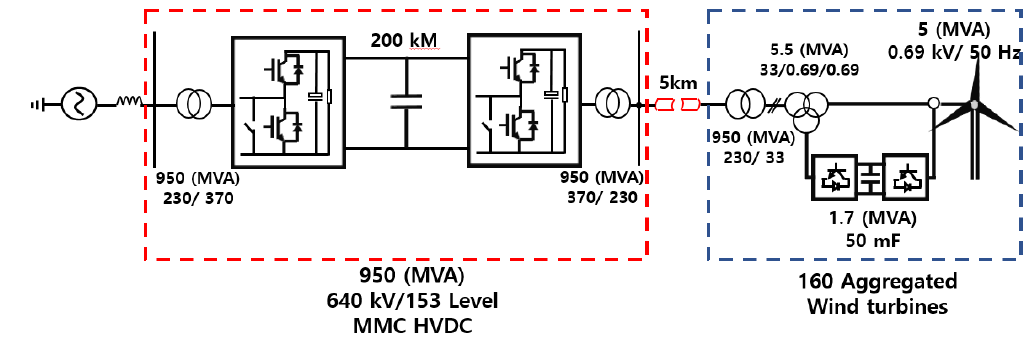
Figure 6. Studied system model of the off-shore wind farm. Table 1. Parameters of the simulated DFIG system.